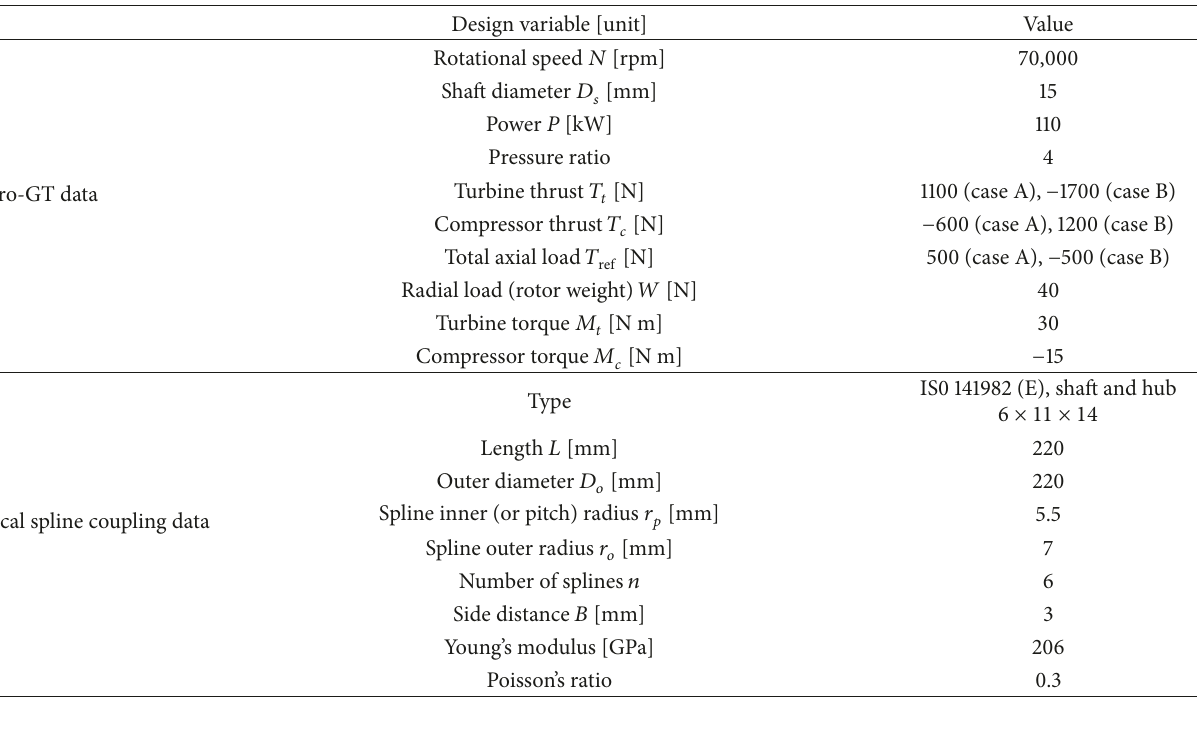
Table 1: Design data of the reference micro-GT unit as well as the spline coupling.